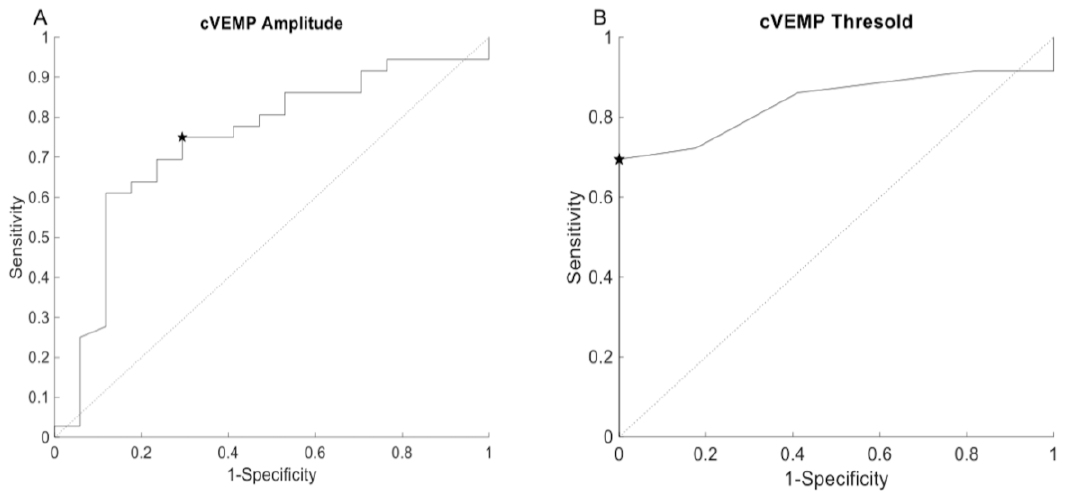
Figure 4. ROC curve representing the diagnostic value of cVEMP amplitude ( A ) and cVEMP threshold ( B ). The star symbol represents sensitivity and specificity for the given cutoff value.